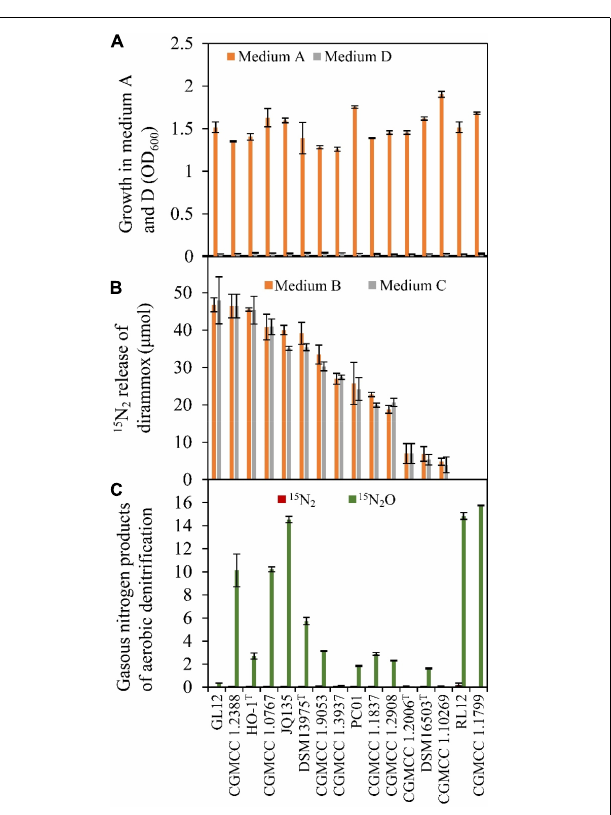
FIGURE 2 | Growth and Dirammox ( dir ect amm onia ox idation) activity of Alcaligenes strains in different medium. (A) Aerobic growth in medium A and medium D, and OD 600 shown here were data of stationary growth phase. (B) 15 N 2 release from ( 15 NH 4 ) 2 SO 4 (initial amount 100 µ mol) in the absence or presence of NaNO 2 (medium B and medium C, respectively). (C) Gaseous products of aerobic denitrification of Alcaligenes strain in medium E (60 µ mol of initial amount of Na 15 NO 2